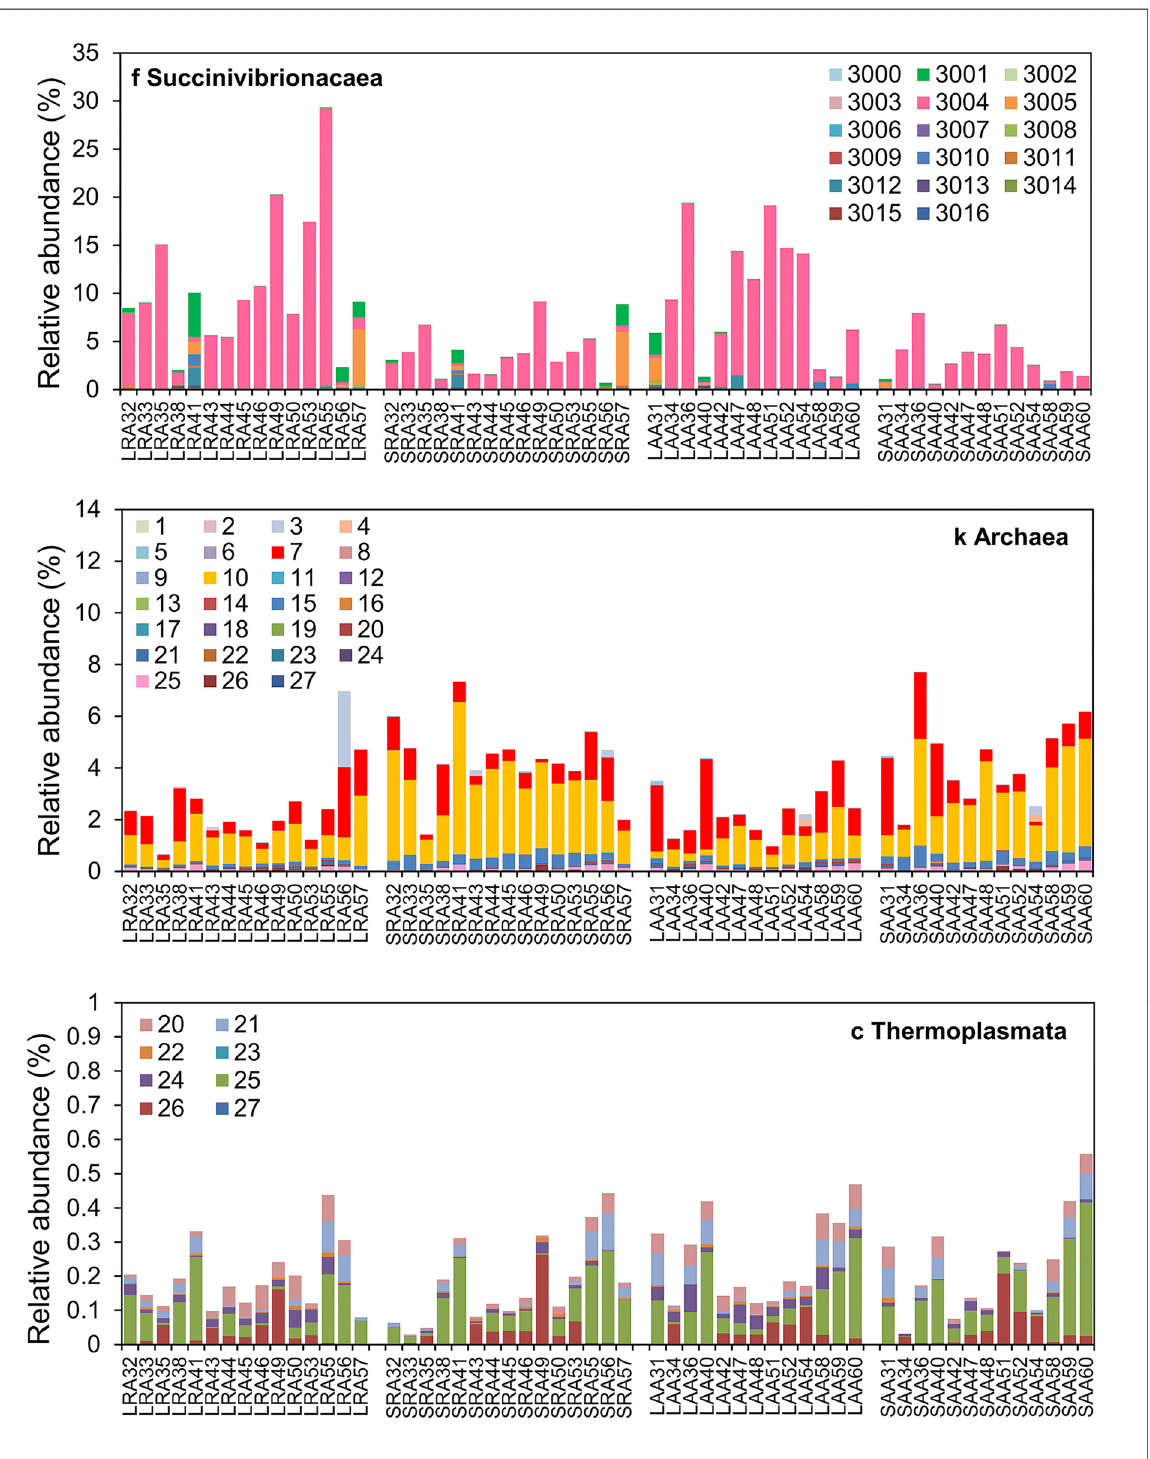
Fig 5. Relative abundance of individual methanogen and Succinivibrionaceae OTUs in group RA and AA. Relative abundance of OTUs identified as family Succinivibrionaceae, kingdom Archaea or class Thermoplasmata (recently reclassified as members of the order Methanomassiliicoccales) in individual liquid (L) and solid (S) rumen samples from groups RA and AA are shown. Different colours represent different OTU numbers. Taxonomic assignments for all OTU numbers are given in S1 Table.